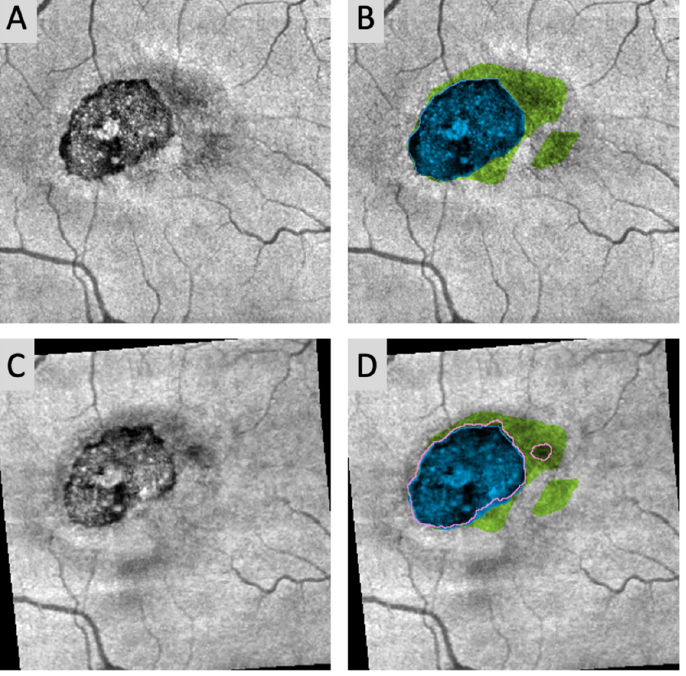
Fig 2. Determining predictive value of IZ loss for future EZ loss. (A) Left eye of a 49-year old with proliferative (OCT Stage 6) MacTel at baseline imaging. (B) Areas of IZ loss (green), and EZ loss (blue; outlined for clarity) at baseline. (C) Same eye imaged at 6-month follow-up, registered to align with (A). (D) EZ loss region at 6-month follow-up (pink outline) superimposed onto B. Note how the new circular area of EZ loss to the right of the main EZ loss area falls entirely within an area of previous IZ